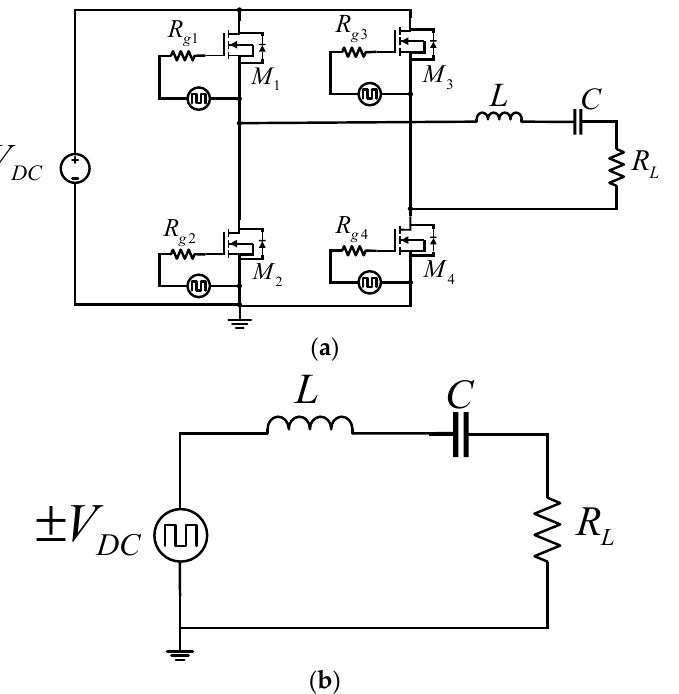
Figure 1. Design methodology for transient state applied to resonant circuits with inverter stage. ( a ) Resonant inverter with series RLC circuit. ( b ) Series RLC equivalent circuit with bipolar voltage source replacing the inverter output voltage.